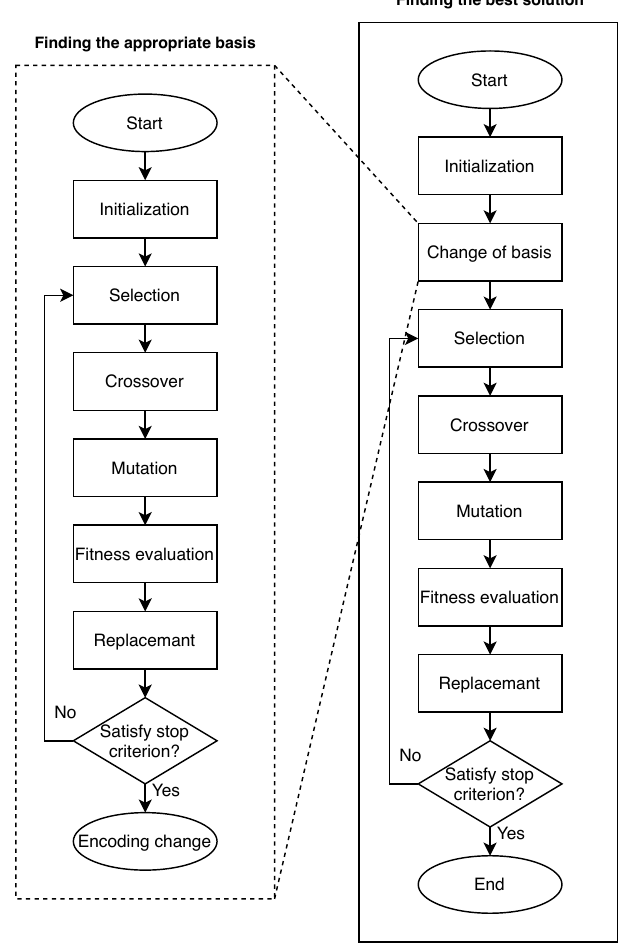
Figure 3. Flowchart of a GA (right-side solid box) with a change of basis which is found by another GA (left-side dotted